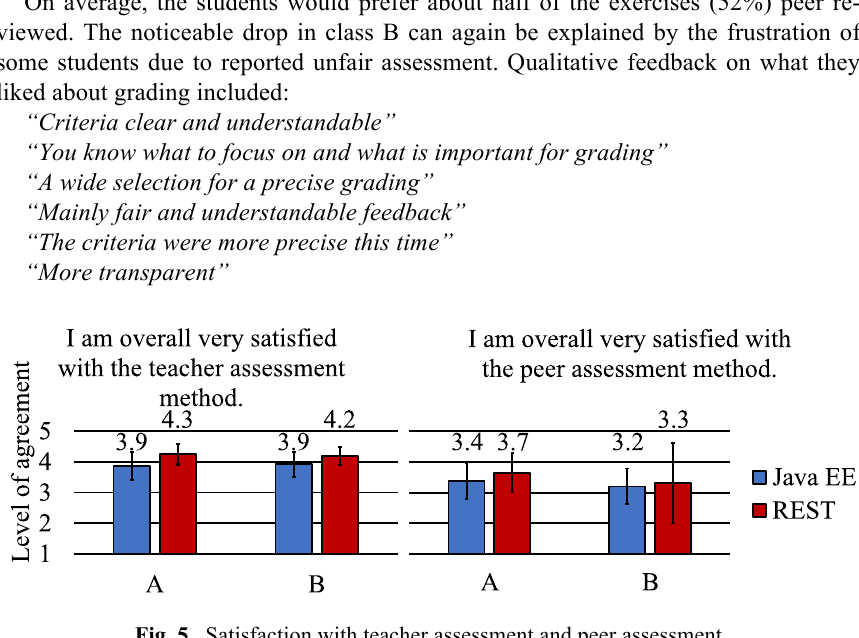
Fig. 5. Satisfaction with teacher assessment and peer